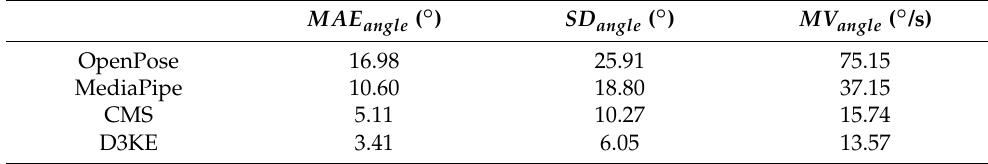
Table 3. Comparison of popular pose estimation algorithms to D3KE. As OpenPose and MediaPipe require multiple cameras to create 3D keypoints, we compare against the average of both camera views for CMS and D3KE. CMS shows better performance than OpenPose and MediaPipe and D3KE shows the overall best performance. Indicating that direct estimation is preferable to (naive) implementations of multi-step methods.